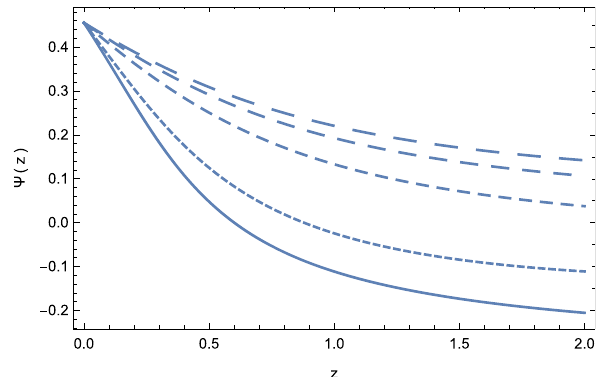
(cid:11) (cid:12) ˜ Q , ˜ T =